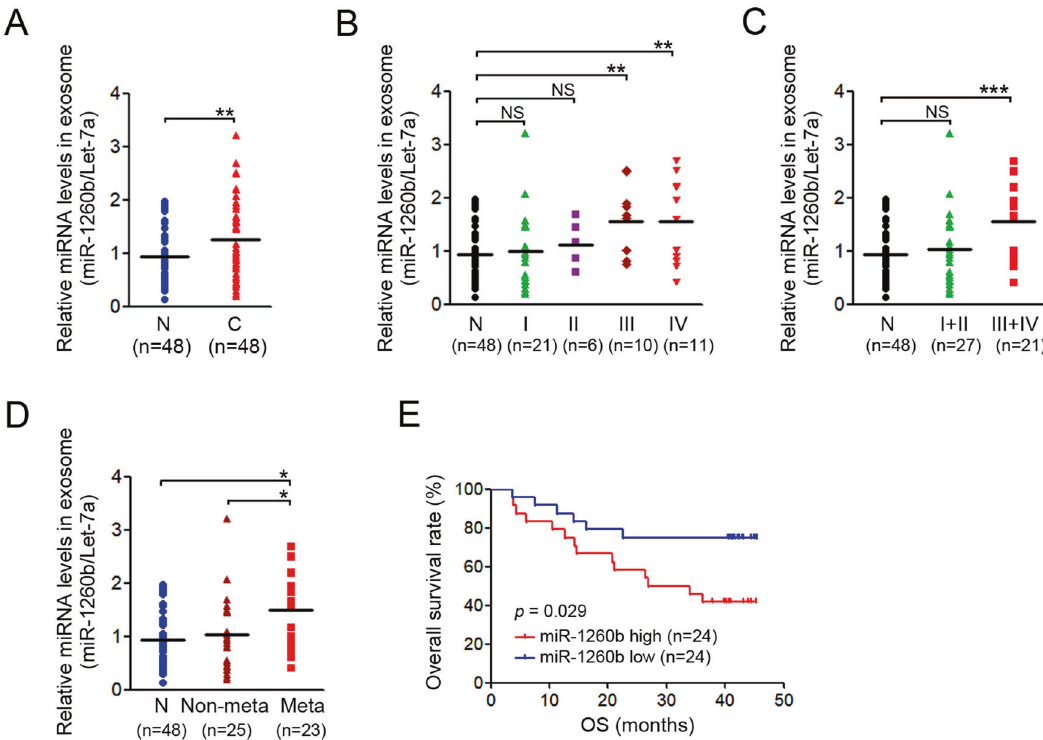
Fig. 5 Pathological features of exosomal miR-1260b in NSCLC. A Exosomal miR-1260b expression in the plasma of healthy donors ( n = 48) and patients with NSCLC ( n = 48). B Expression levels of exosomal miR-1260b were analyzed according to different stages, including C